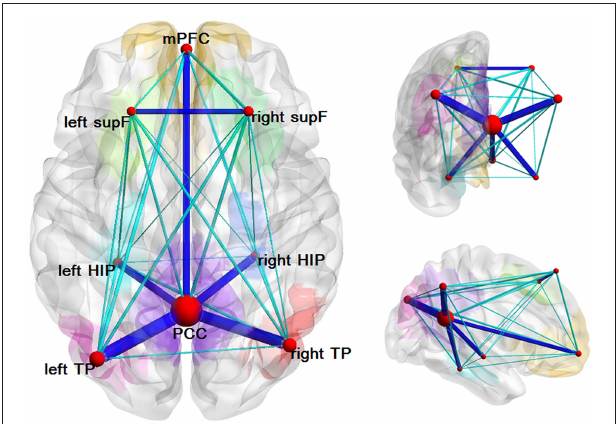
FIGURE 4 | Structural network of the DMN. Eight ROIs and the structural connectivity between any two regions are shown in this graph. The size of the node corresponds to the degree of the node and the connectivity was thresholded by 0.1 with dark blue indicating values greater than 0.1 and light blue indicating values less than